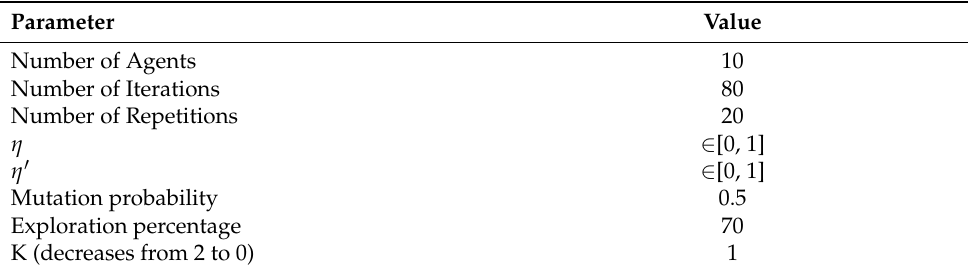
Table 1. Parameters for BERSFS algorithm configuration.